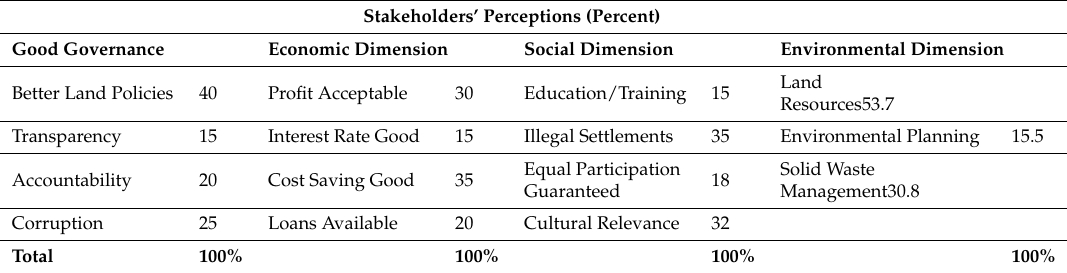
Table 5. Indicators of ILG Sustainability: Perceptions of ILG stakeholders who thought that each indicator (parameter) was the most